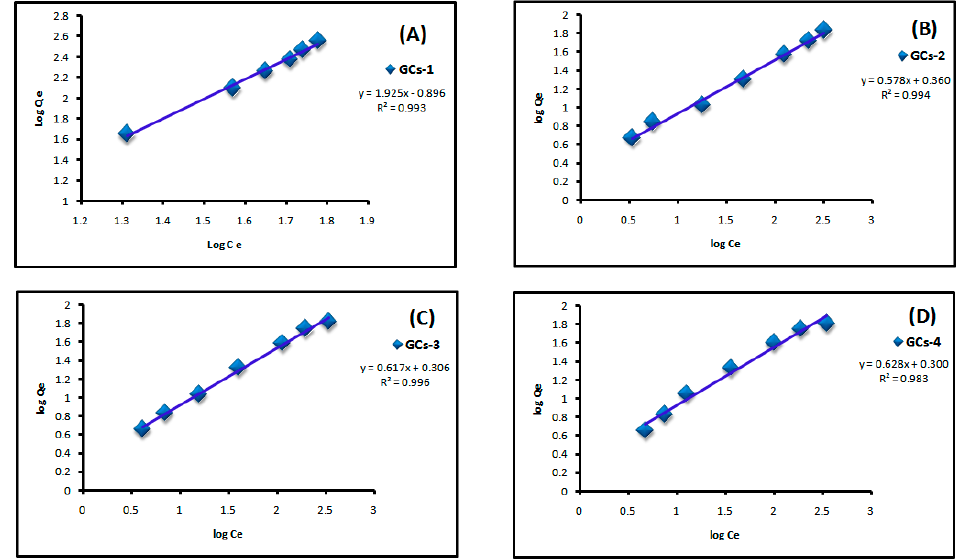
Figure 10. Freundlich plot for Cu(II) adsorption on to ( A ) GCs-1; ( B ) GCs-2; ( C ) GCs-3 and ( D ) GCs-4.